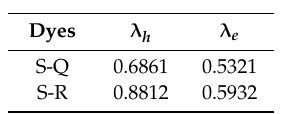
Table 4. The reorganization energies of hole ( λ h ) and electrons λ e of S-Q and